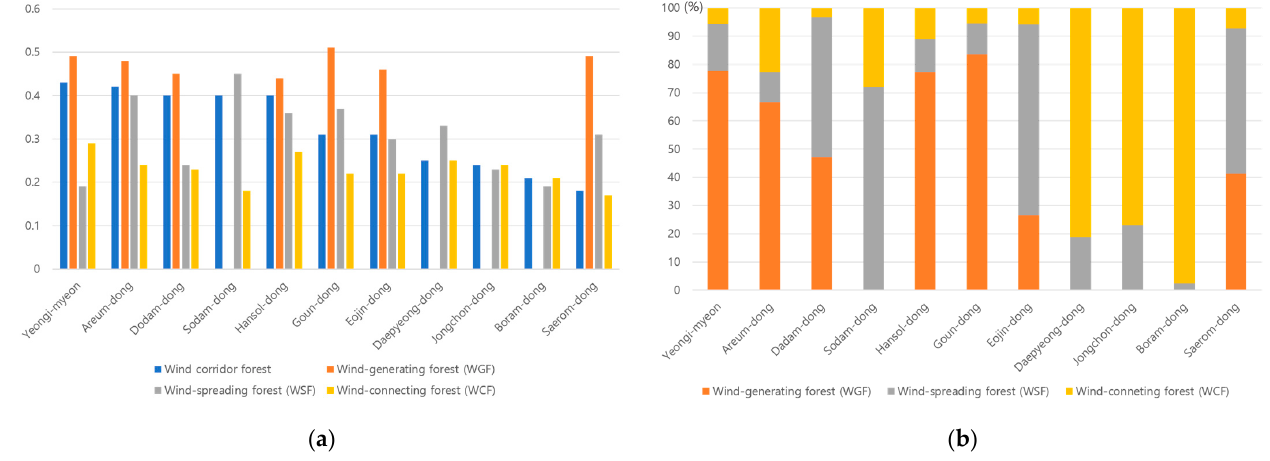
Figure 11. Comparison of wind corridor forest properties by administrative districts: ( a ) vegetation index of wind corridor forests; ( b ) proportion of three types of wind corridor forest.